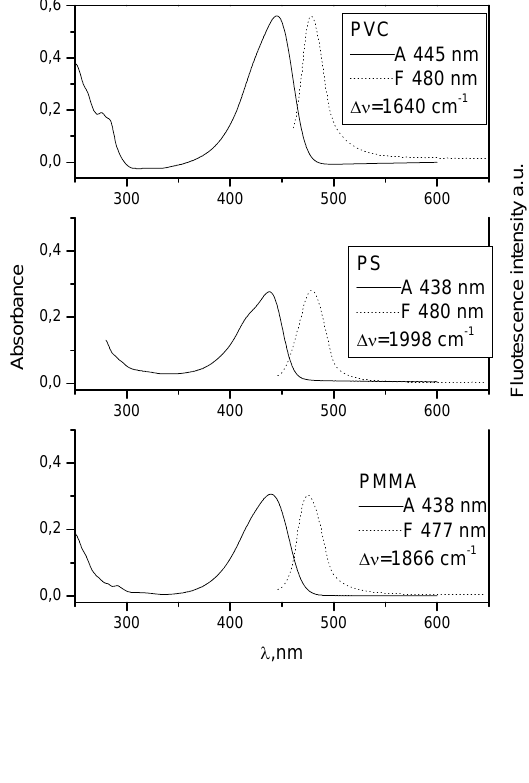
Figure 3 . Absorption and fluorescence spectra of 7 in PMMA, PS and PVC at 0.002 mol kg − 1